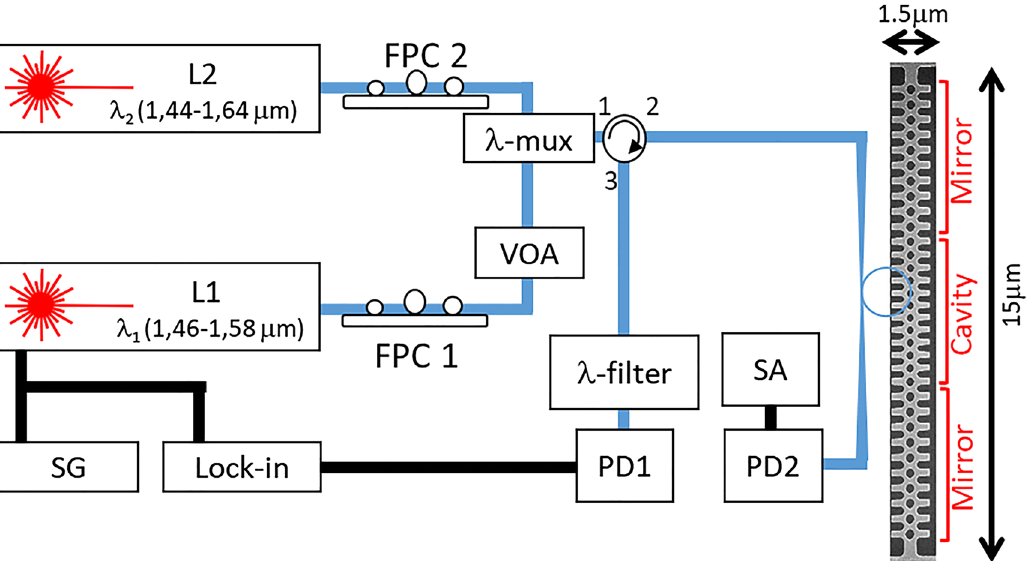
Figure2: Schematicsoftheexperimentalsetuptomeasurethepropertiesoftheoptomechanicalnanobeams.Ataperedfiberloopisplacedin closeproximitytotheOMCnanobeam,shownintheSEMimage(notinscale).L1andL2aretunablelasers, λ -muxisawavelengthmultiplexer, λ - fi lter is a Fabry – Perot wavelength fi lter, SG denotes a signal generator, VOA is a variable optical attenuator, FPC1 and FPC2 are the fi ber polarizer controllers, SA stands for a spectrum analyzer and PD1 and PD2 denote the photodetectors. The signals can be detected in transmission or re fl ection mode. OMC, nanoscale optomechanical